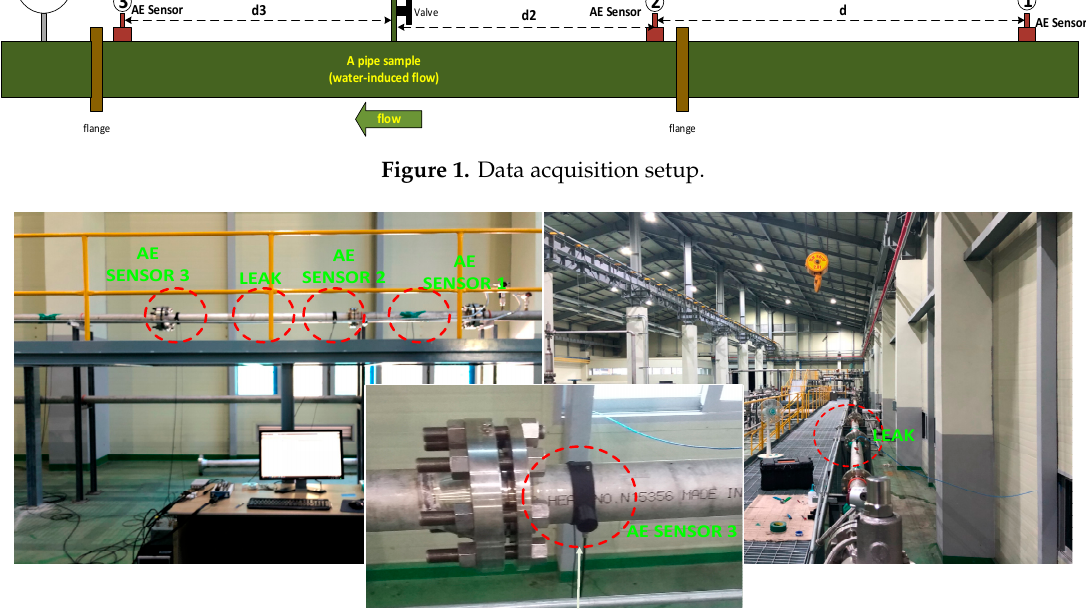
Figure 2. The testbed for pipeline leak detection.